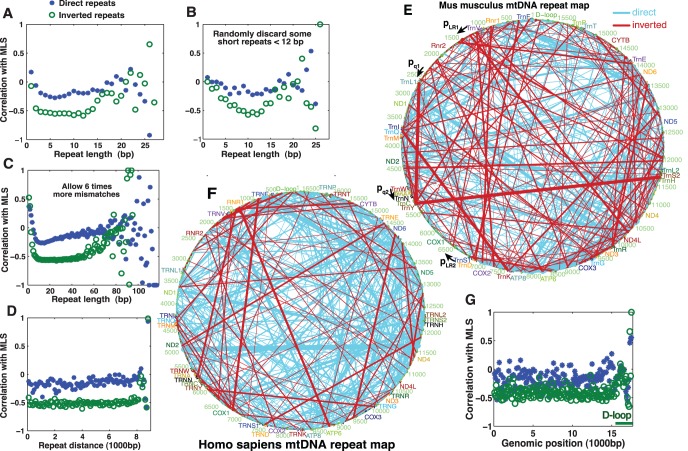
The influence of repeat length, distance between repeats, and genomic position on the correlation between mutagenic score and maximum lifespan (MLS).(A) Effect of repeat length on the correlation between mutagenic score and MLS. (B) Short repeats show weaker correlation with MLS if their total number is made equal to the number of long repeats by randomly discarding some of the short repeats. Each repeat was discarded with probability 1–3i
 –12 (i is the number of identical matches) so that repeats shorter than 12 bps had nearly the same expected number (3 is used instead of 4 because 1/4 shorter repeats, which were inside longer repeats, were not counted). (C) Effect of mismatches on the correlation between mutagenic score and MLS. (D) Effect of the distance between repeats on the correlation between mutagenic score and MLS. (E, F) Repeat maps showing all repeats longer than 10 bp. Line thickness is proportional to repeat length, with the thinnest lines representing the shortest repeats (11 bps), and the thickest lines representing repeats of about 19 bp. pLR1 and pLR2 indicate the positions of PCR primers used for long range (LR) PCR; pq1 and pq2 indicate the positions of primers used for qPCR. (G) Effect of genomic position of the repeats on the correlation with MLS. The starting position of tRNA-Phe is used as position 1 for all mammals. The correlations at the end of D-loop were not statistically significant, as sequence information for the D-loop is only available for a small number of species.